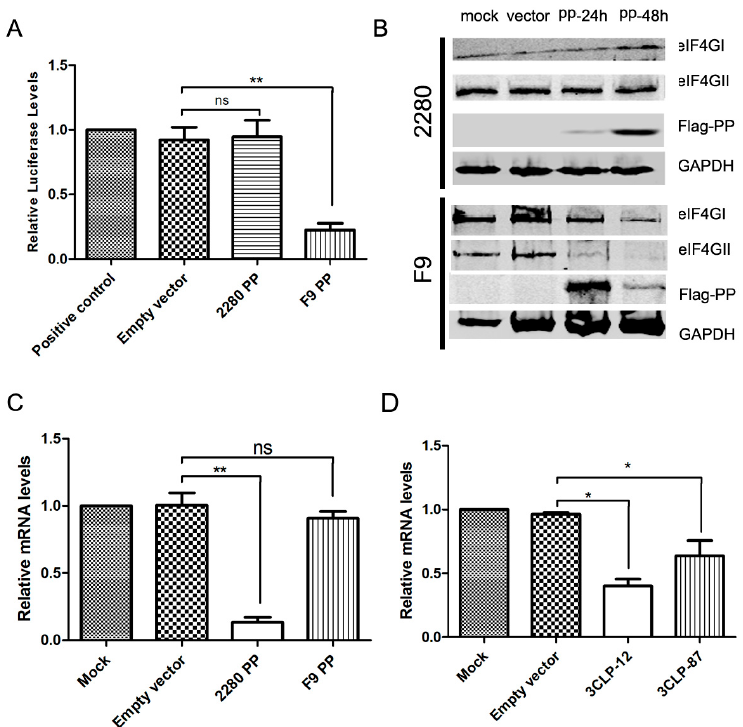
Figure 5. Analysis of PP inhibition of host gene transcription. ( A ) Effect of PP on mRNA translation. CRFK cells were transfected with 0.25 µ g of capped luciferase mRNA together with 0.25 µ g of pFlag-2280 PP and pFlag-F9 PP or empty vector. No transfection or transfection with capped luciferase mRNA only were used as the negative control and positive control, respectively; ( B ) Effect of PP on the expression of the translation initiation factors eIF4GI and eIF4GII. CRFK cells were transfected with 1 µ g of pFlag-2280 PP and pFlag-F9 PP or empty vector for 24 and 48 h, and the expression of eIF4GI and eIF4GII was determined by Western blotting using anti-eIF4GI and -eIF4GII antibodies; ( C , D ) Effect of PP and 3CLP on gene transcription. CRFK cells were transfected with 0.25 µ g of pIFN+33-Luc together with 0.25 µ g of pFlag-2280 PP and pFlag-F9 PP ( C ) and pFlag-3CLP-12 and -3CLP-87 ( D ) or empty vector. Transfection with pIFN+33-Luc only was used as a positive control. The levels of luciferase mRNA were determined by qPCR. Three independent experiments were performed and produced consistent results. The data represented the result of one experiment and were presented as means ˘ SD. *, p < 0.05; **, p < 0.01; ns,